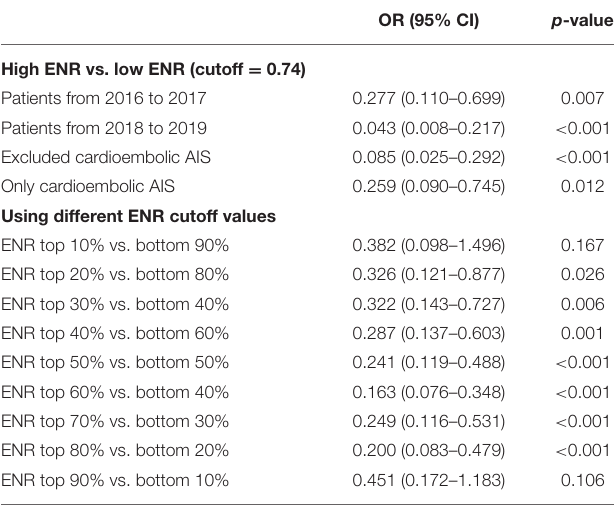
OR (95% CI) p -value